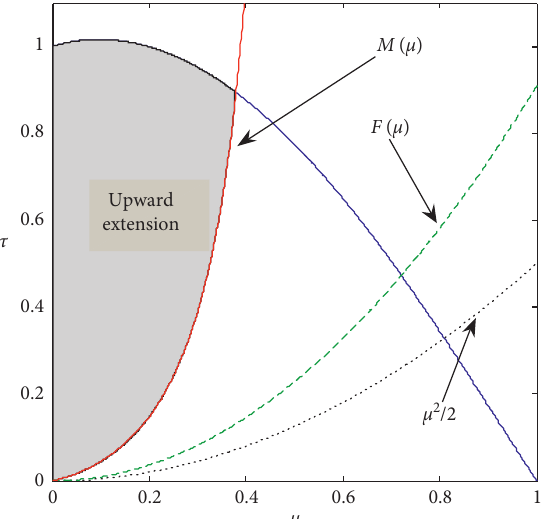
Figure 7: The strategic choices of the low-quality firm.